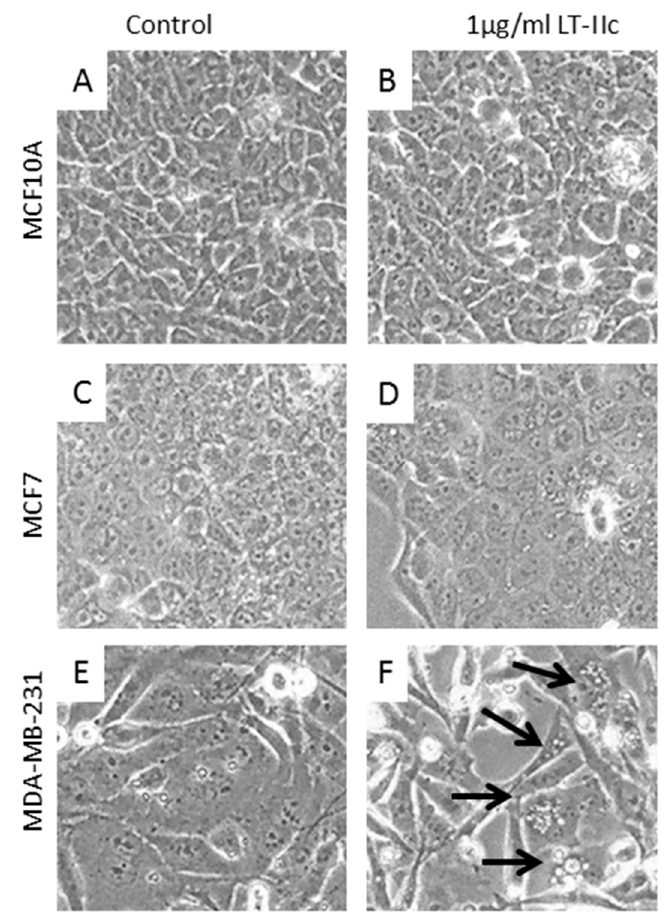
Figure 2. LT-IIc did not induce morphologic change in the immortalized human breast epithelial MCF10A ( A , B ), or ER positive MCF7 human breast cancer cell lines ( C , D ). LT-IIc induced extensive intracellular vacuolation (arrows) in MDA-MB-231 ( E , F ). All cells were treated with 1 µg/mL LT-IIc for 24 h. Cell images were obtained using a 40× objective under phase contrast illumination.